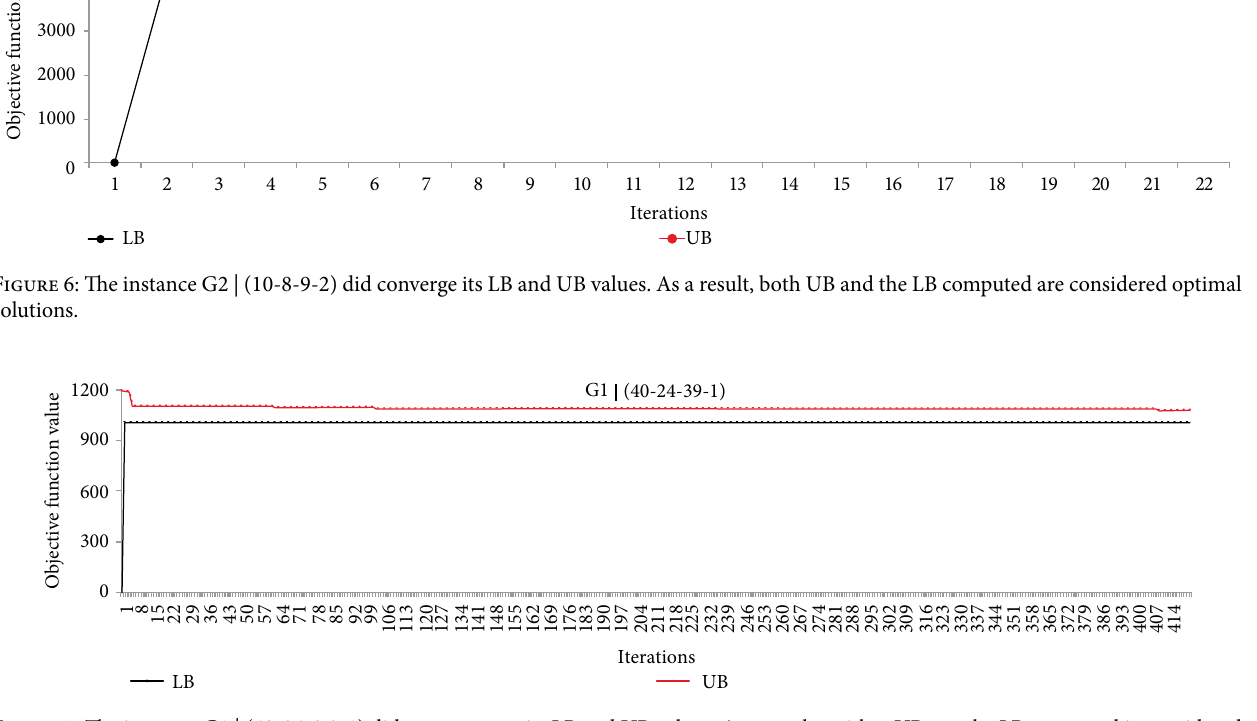
Figure 7: The instance G1 | (40-24-3 9-1) did not converge its LB and UB values. As a result, neither UB nor the LB computed is considered as optimal